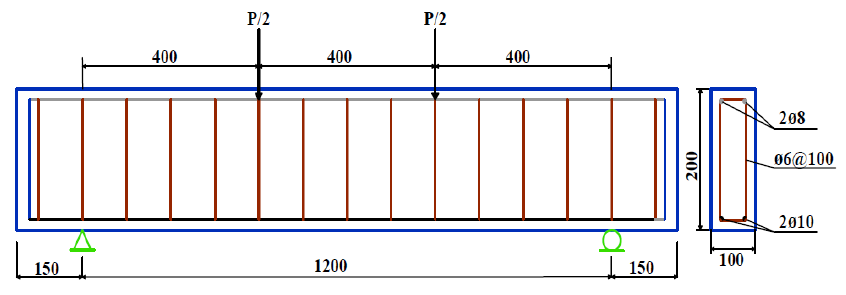
Figure 9. Detailed Geometry of Murthy et al. Specimen (CBA) [49].